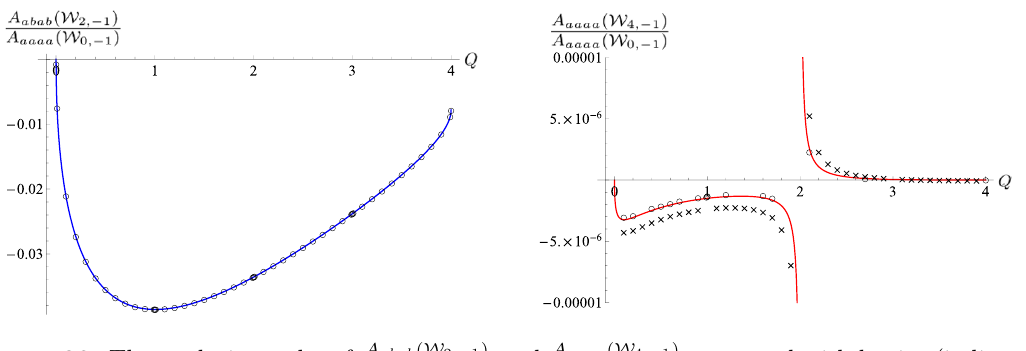
Figure 29 . The analytic results of A abab ( W 2 , − 1 ) with × ) and reduced bootstrap results (indicated with ).